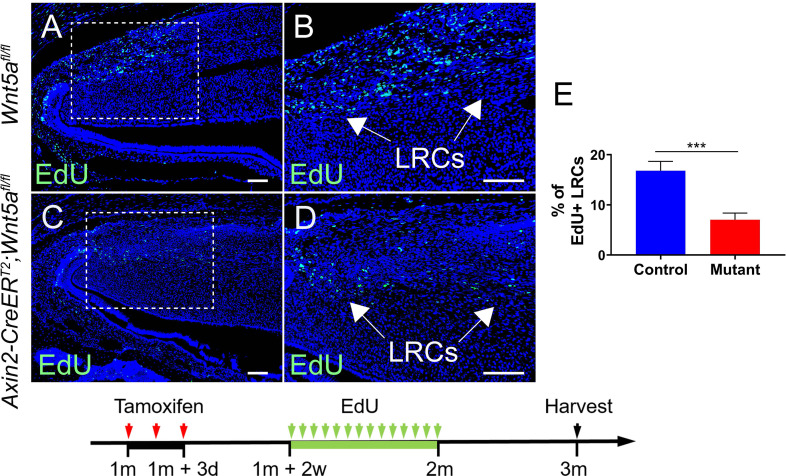
Loss of Wnt5a results in diminished EdU+ label retaining cells (LRCs).(A–D) EdU staining of Wnt5afl/fl and Axin2-CreERT2;Wnt5afl/fl mouse incisors. (E) Quantification was performed by calculating the percentage of EdU+ cells per section under higher magnification (B and D) in Wnt5afl/fl and Axin2-CreERT2;Wnt5afl/fl mouse incisor mesenchyme. Schematic underneath figures indicates induction protocol. All quantitative data are presented as mean ± SD. ***, p<0.001. Scale bars, 100 μm.Figure 5—figure supplement 2—source data 1.Source data for Figure 5—figure supplement 2E.